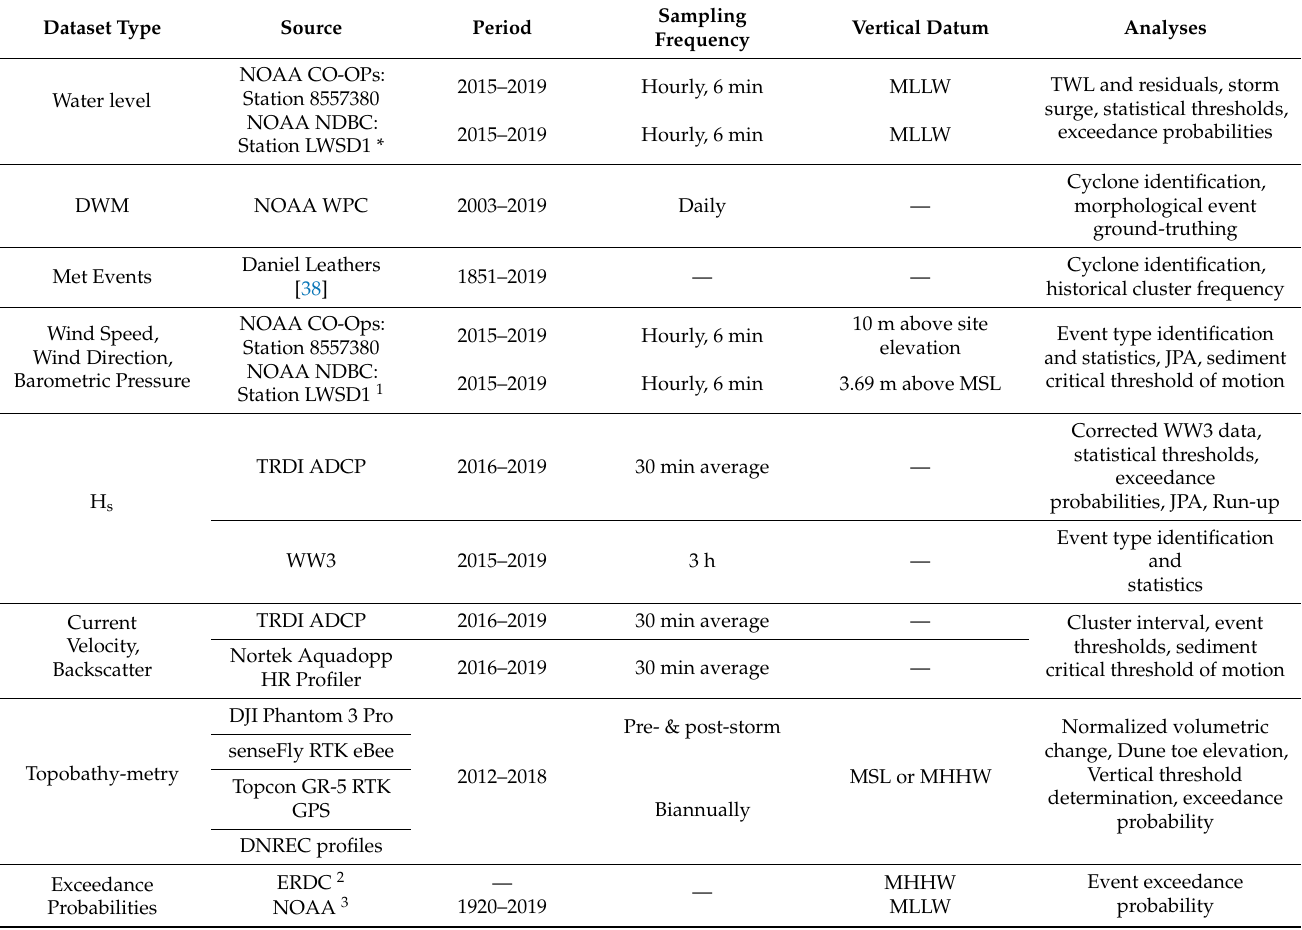
Table A1. Metadata for the field campaigns and publically available data used in the analyses.